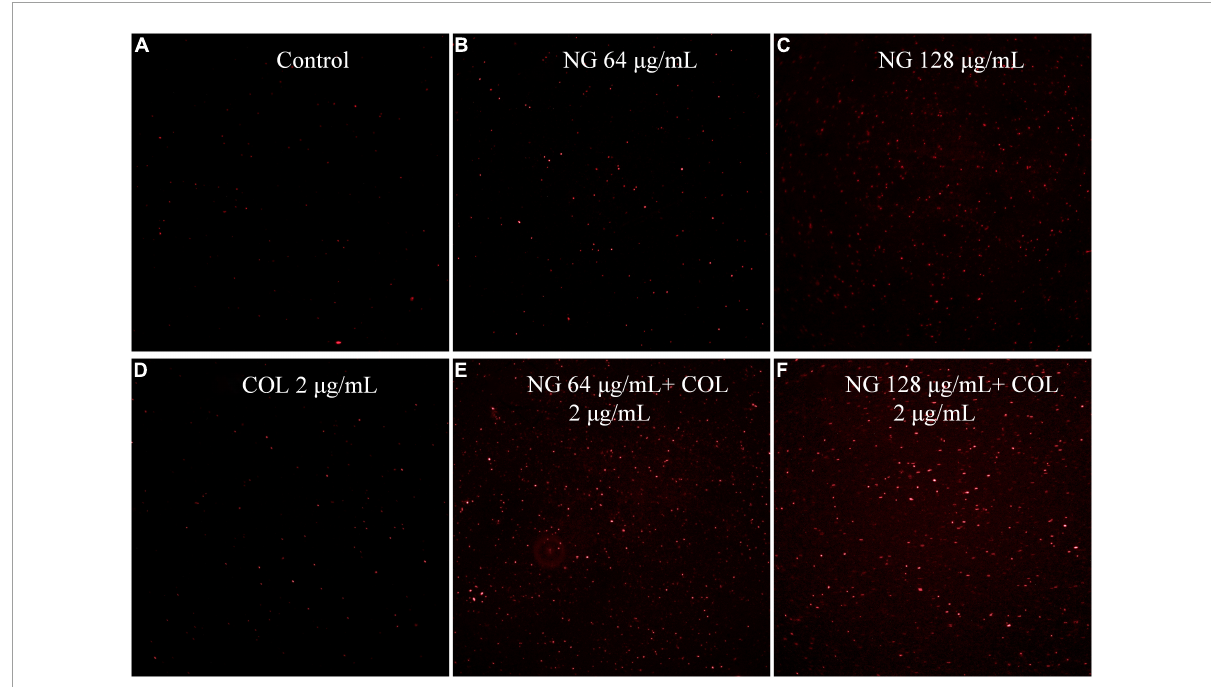
FIGURE2 Fluorescence microscopy imaging of exponential-phase Klebsiella pneumonia FK1913, which were treated with naringenin and colistin alone or in combination, and incubated with 50 µ g/ml PI for 10 min before imaging. (A) LB broth control; (B,C) cells treated with naringenin at 64, 128 µ g/ml; (D) cells treated with colistin with 2 µ g/ml; (E,F) cells exposed to a combination of naringenin and colistin. Naringenin (NG) and colistin